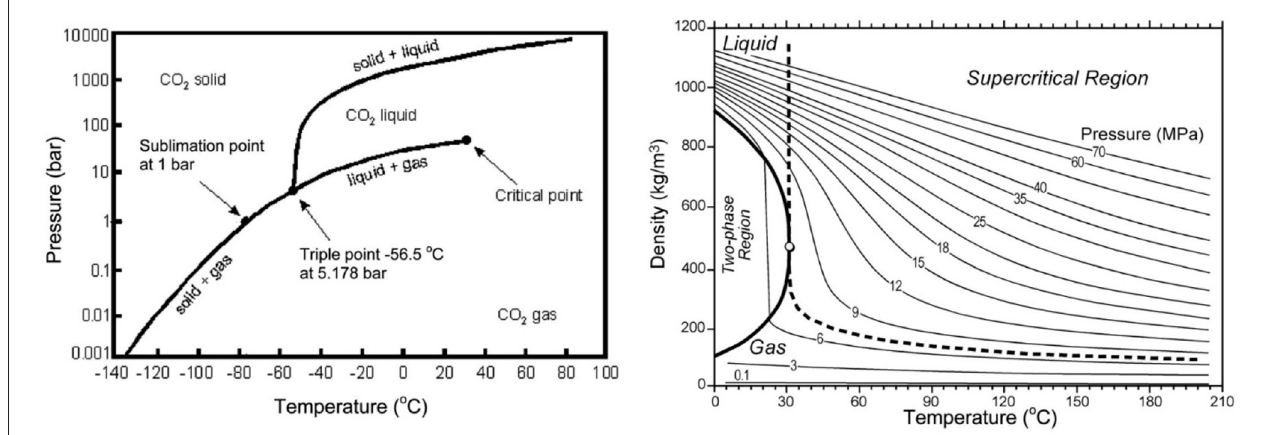
FIGURE 2 | Phase diagram of carbon dioxide (source: